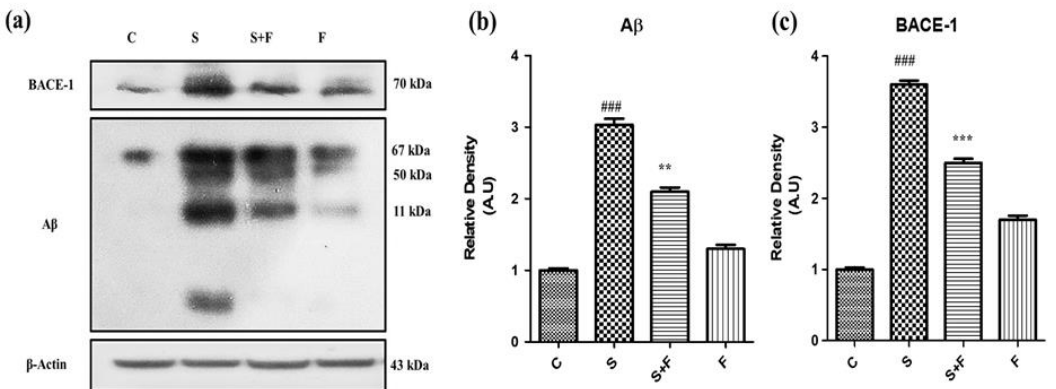
Figure 3. Friedelin abolished the amyloidogenic pathway of Aβ production against scopolamine. The immune blot analysis of markers of amyloidogenic pathway i.e., BACE- 1 and Aβ of control vs. scopolamine and combination treatment of scopolamine and friedelin is shown in ( a ), while the respective histograms are placed at ( b , c ). The results were expressed in arbitrary unit (A.U) and were determined using ImageJ software and histogram indicate mean A.U ± SEM. Significance of control vs. scopolamine is expressed as # , while * denotes scopolamine vs. scopolamine + friedelin. ** p < 0.01 and *** , ### p < 0.001.